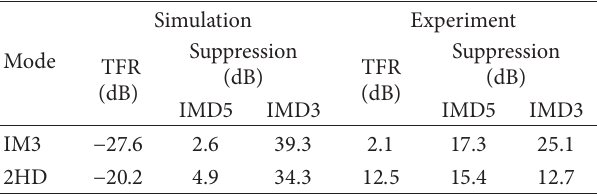
Table 3: Comparison of TFR and IMD suppression between simulation and